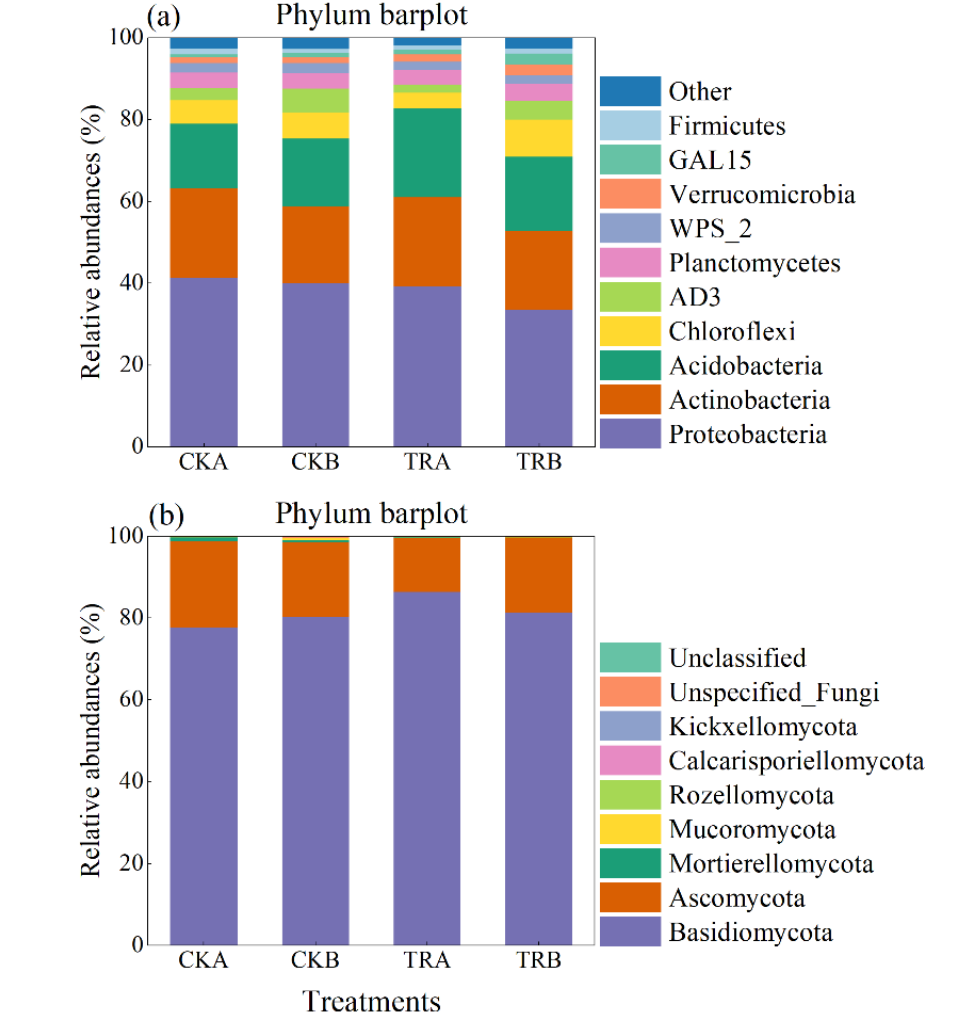
Figure 3. Relative abundance of the dominant bacterial ( a ) and fungal ( b ) groups at the phylum level under different treatments. Table 2. Diversity indices of fungal and bacterial community in Eucalyptus plantations.